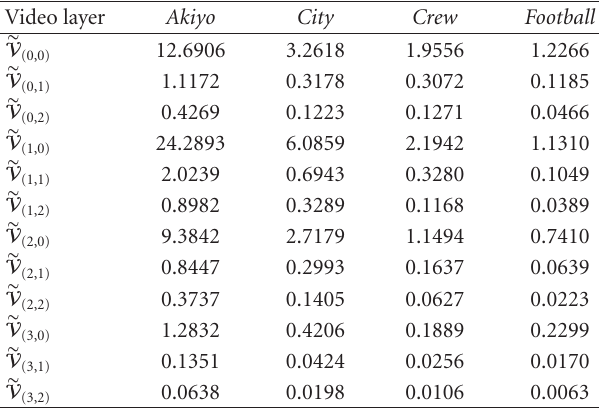
Table 3: Utility for di ff erent standard videos. Video